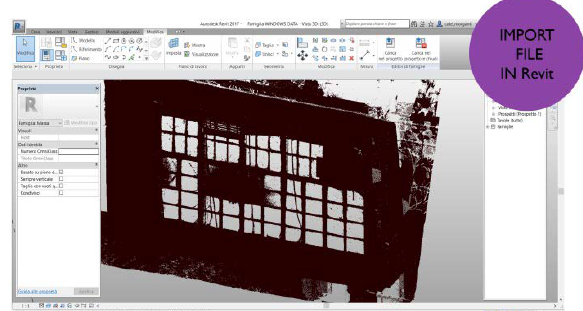
Figure 18: Element extention.dwg import in Revit.